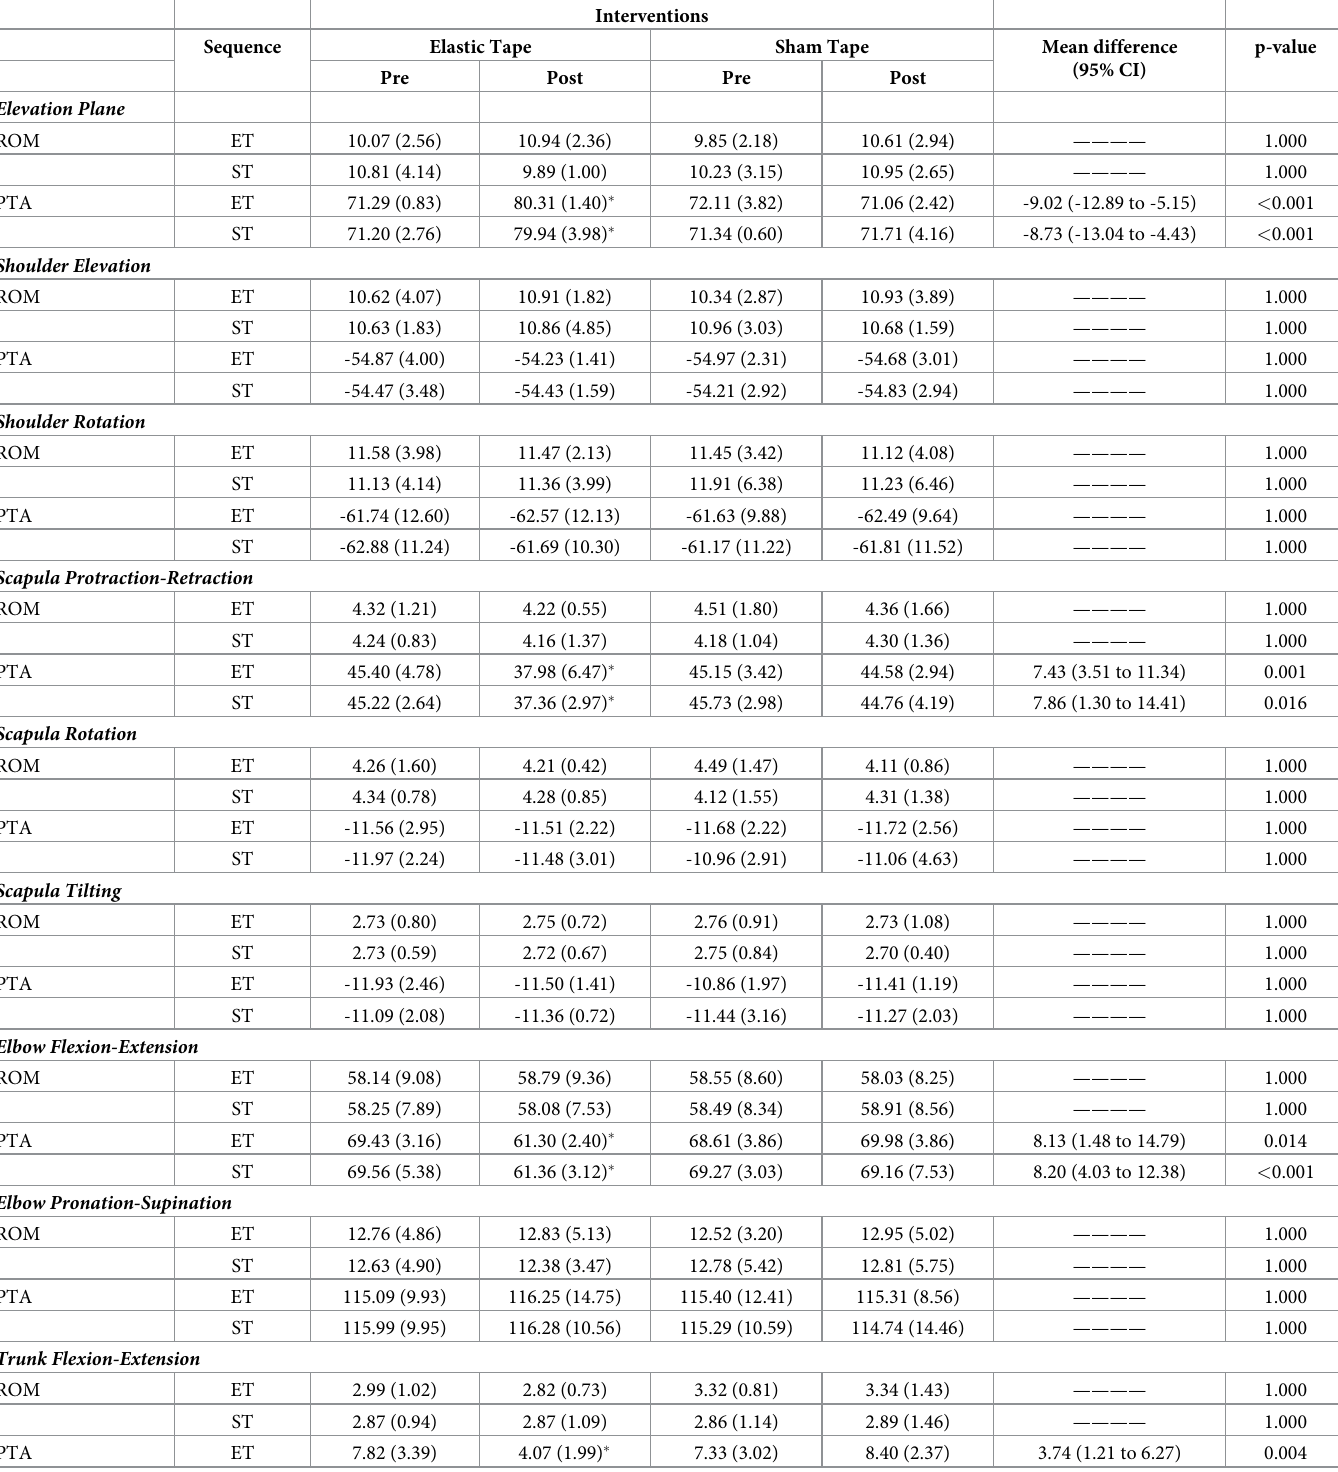
Table 3. ROM and PTA for all joints assessed while transporting the glass to the table for both sequences (groups: ET and ST) pre and post-interventions (elastic and sham tape). Interventions Sequence Elastic